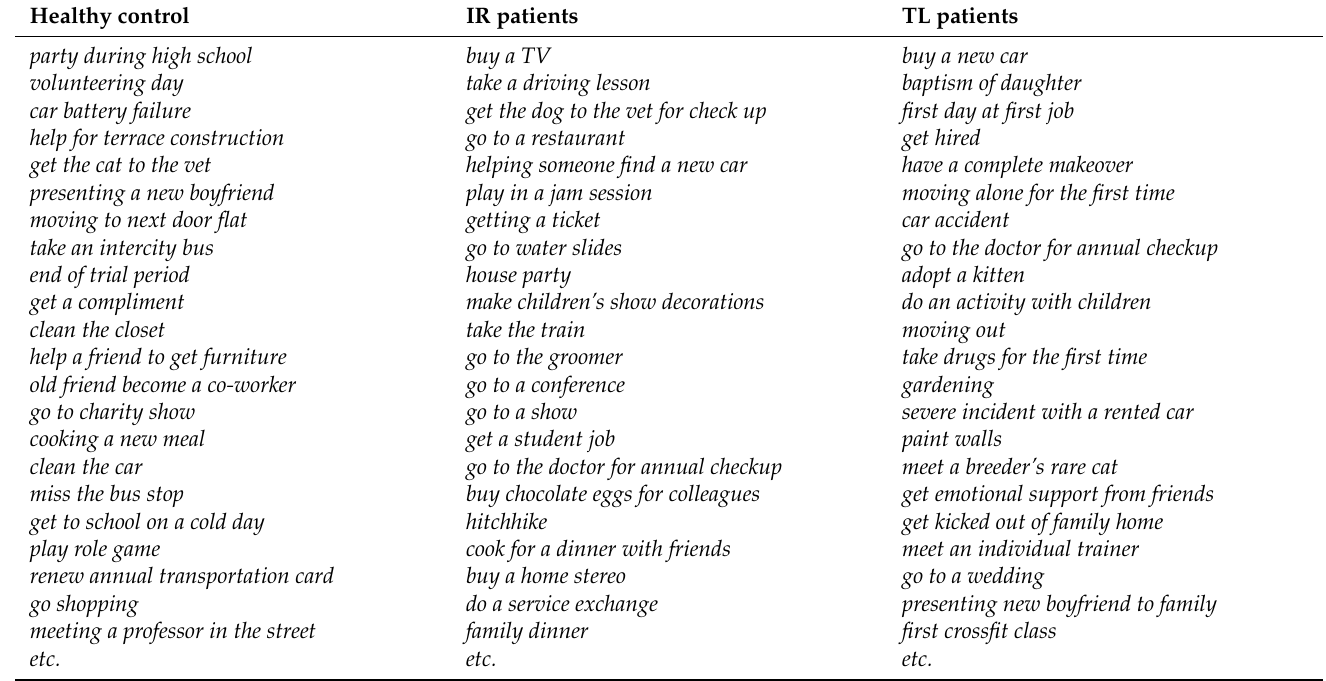
Table 5. Examples of neutral memories evoked by